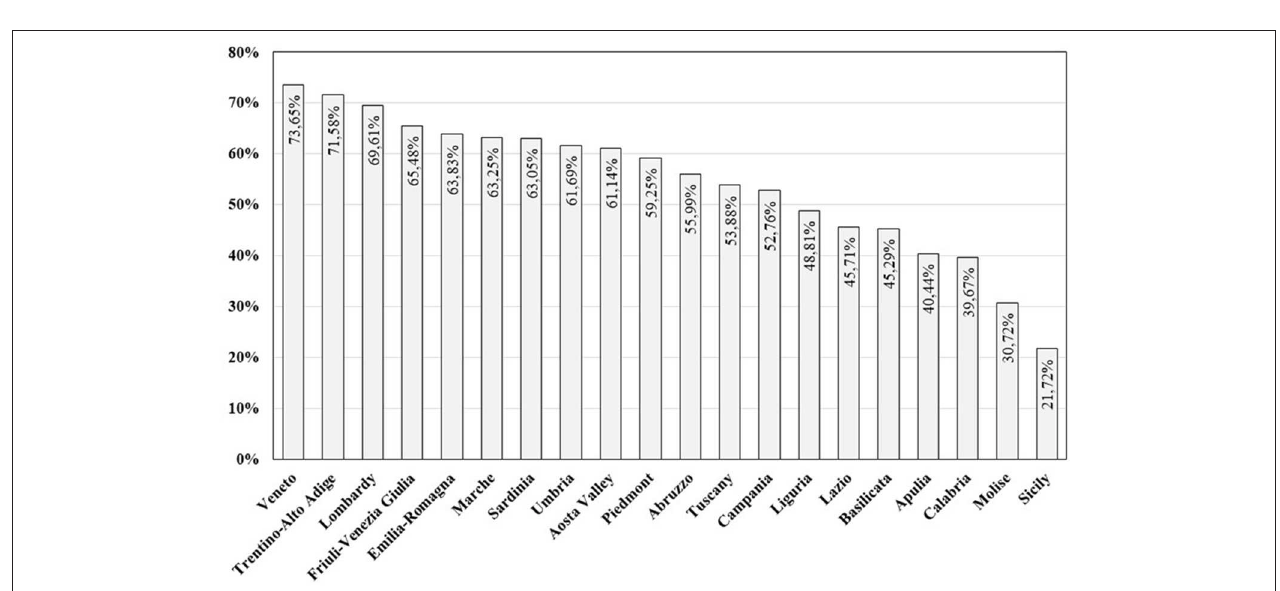
FIGURE 1 | Percentage of separated waste by regions, 2017 (our elaboration on data from ISPRA).